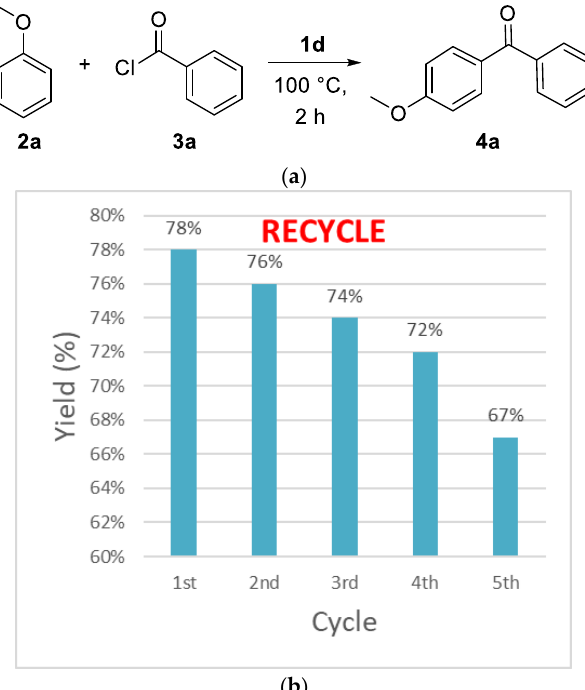
Figure 2. ( a ) Friedel-Crafts acylation reaction ( b ) Recycling of 1d in the synthesis of (4-methoxyphenyl) phenyl-methanone 4a .